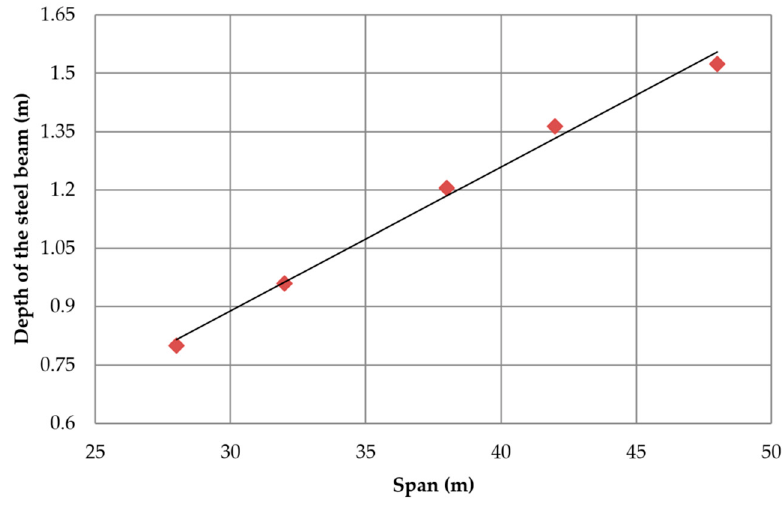
Figure 9. Mean steel beam depth for different span lengths.